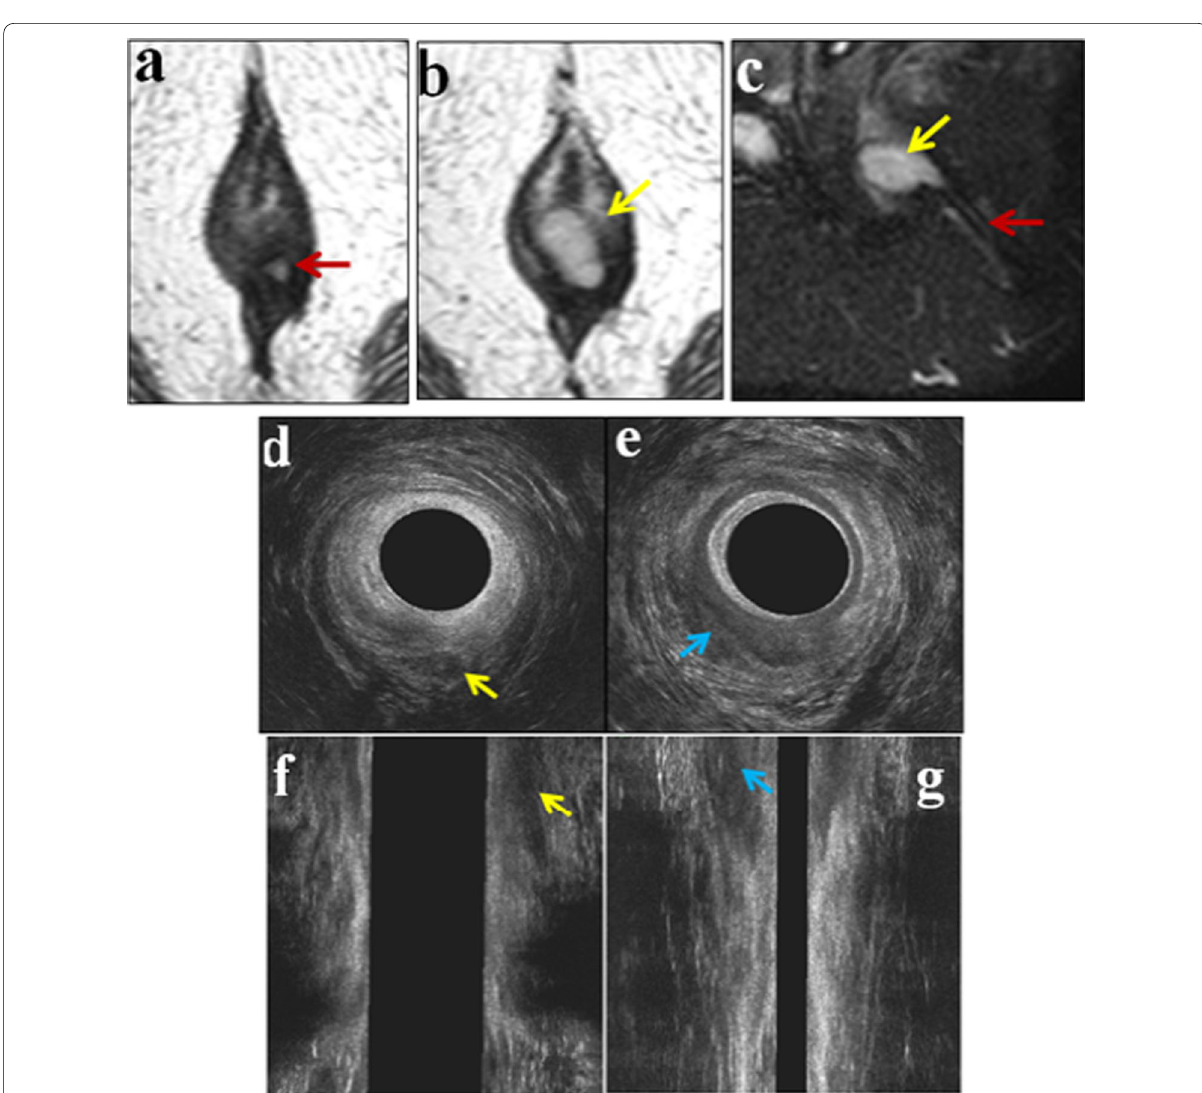
Fig. 6 a , b , c MRI axial T2 and sagittal STIR WI images show left posterior high trans‑sphincteric fistulous tract (red arrows) seen crossing the midline at the level of deep portion of external anal sphincter ending in right inter‑sphincteric collection between 6–9 o’clock eliciting high T2&STIR signal (yellow arrows). d , f ultrasound axial and post reconstruction coronal images show left posterior high trans‑sphincteric hypoechoic fistulous tract (yellow arrows) seen breaching the deep portion of the external anal sphincter and ending in right posterior and midline hypoechoic collection e , g with internal echogenic foci between 6–9 o’clock (blue arrows) at the level of the right puborectalis